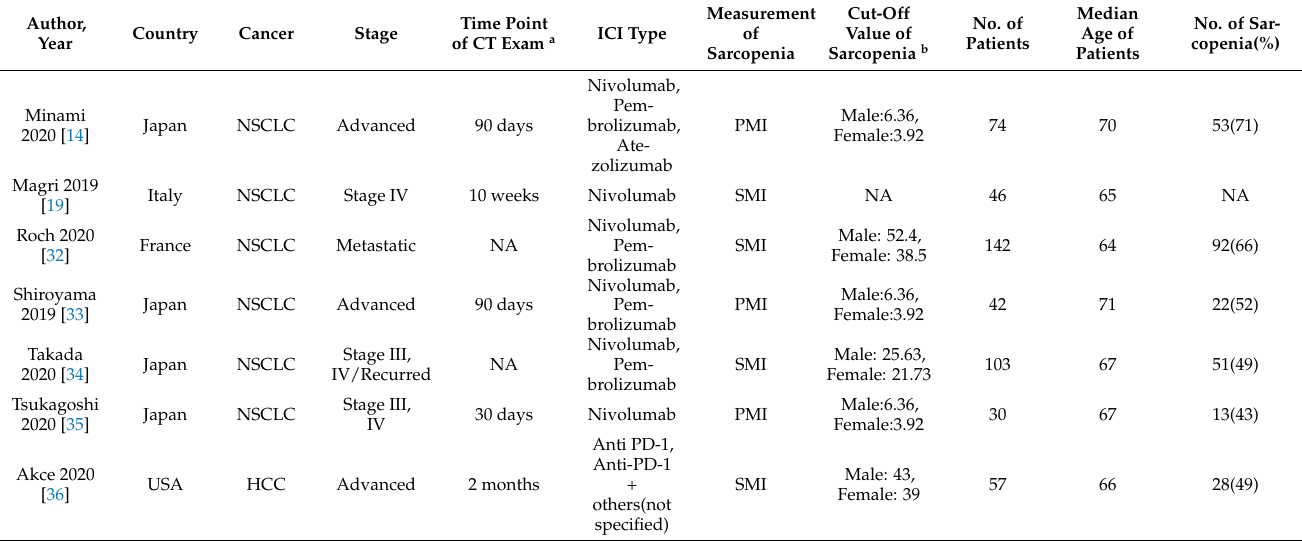
Figure 1. Flow diagram of the study selection process. Abbreviation: HR, hazard ratios. Table 1. Characteristics of the studies included in the